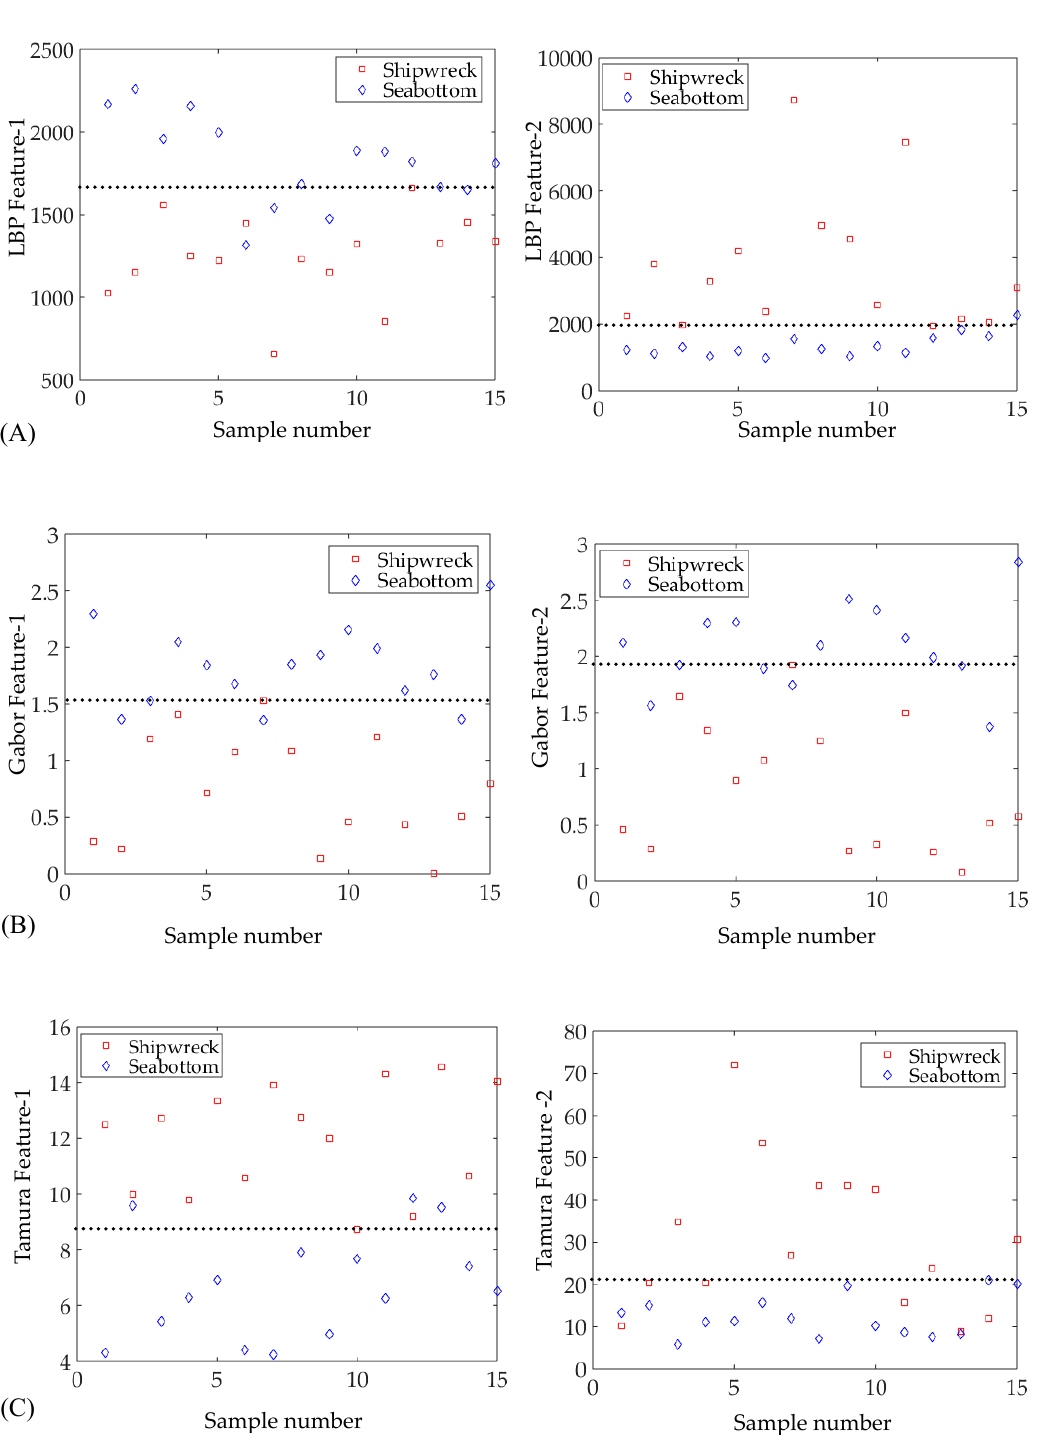
Figure 8. The value of other texture features calculated by SSS images of shipwreck and sea bottom. The black dotted line represents the feature distinguishing value. ( A ) shows the first two dimensions of local binary pattern (LBP) features, ( B ) shows the first two dimensions of Gabor features, ( C ) shows the first two dimensions of Tamura features.